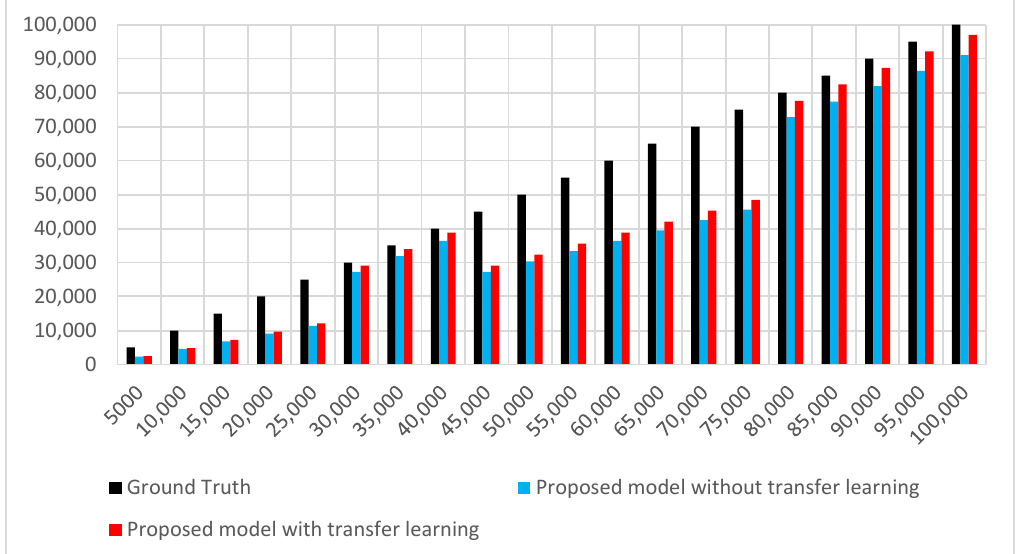
Figure 11. The effect of the training data size on the classification accuracy of the proposed models compared to the ground truth.